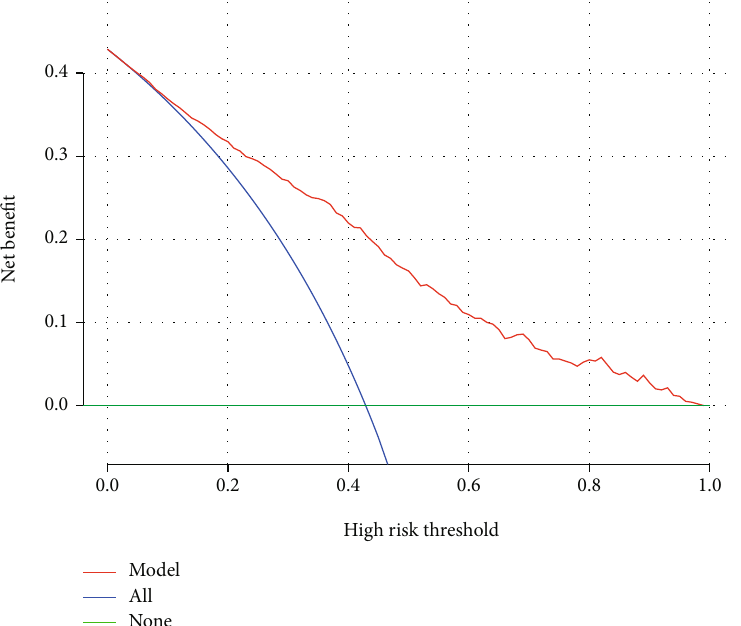
Figure 3: Decision curve analysis for the prediction model. A horizontal line indicates that all samples are negative and not treated, with a net bene fi t of zero. An oblique line indicates that all samples are positive. The net bene fi t has a negative